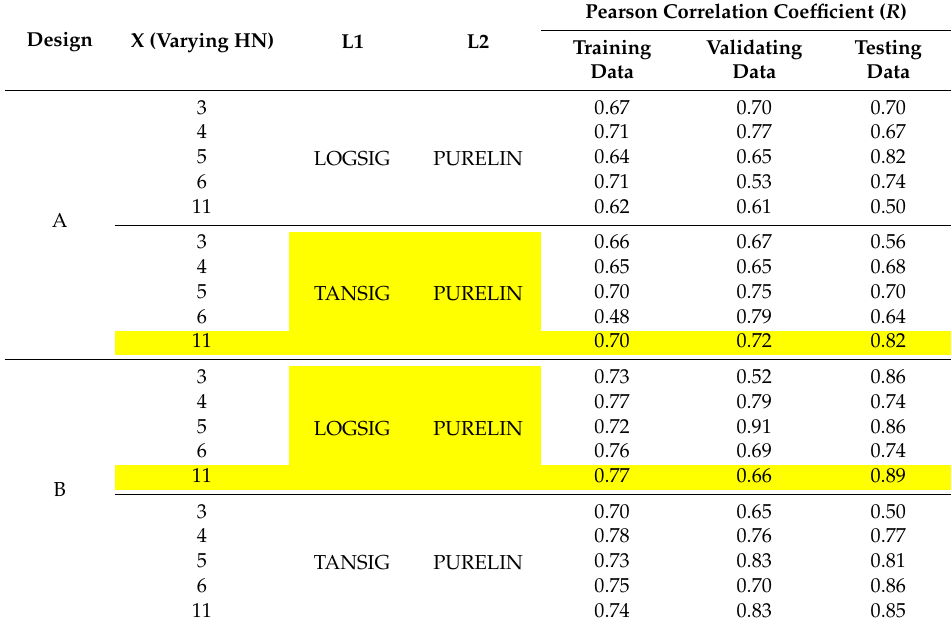
Table 3. Trained, validated, and tested ANN models for WC60